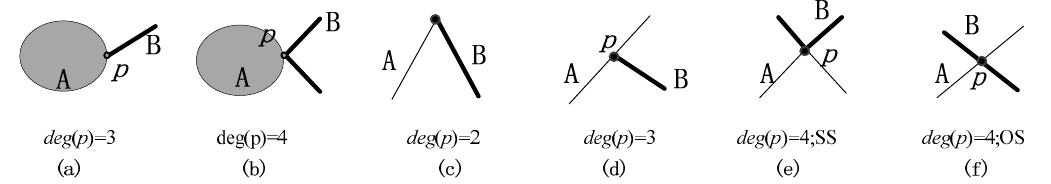
Figure 12. Six types of possible and asymmetric intersection-points of line/region and line/line. ( a ) The degree value of intersection-point between line/region is three; ( b ) The degree value of intersection-point between line/region is four; ( c ) The degree value of intersection-point between lines is two; ( d ) The degree value of intersection-point between lines is three; ( e ) The degree value of intersection-point between lines is four, and its comprehensive adjacent point kind is SS; ( f ) The degree value of intersection-point between lines is four, and its comprehensive adjacent point kind is OS.4. Hierarchical Representation of the Topological Relations of Line/Region and Line/Line .